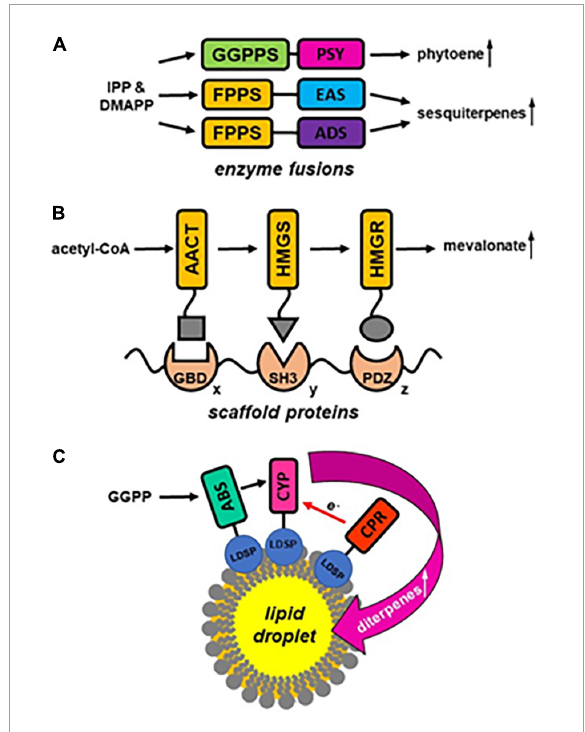
FIGURE2 Engineering approaches utilizing metabolic channeling for improved terpenoid formation. (A) Enzyme fusion strategy: fusion of prenyltransferases (GGPPS, FPPS) with phytoene synthase (PSY) and terpene synthases ( epi -aristolochene synthase EAS, amorpha-4,11-diene synthase ADS), respectively, leads to increased substrate (IPP, DMAPP) conversion to product formation. (B) Synthetic scaffold protein strategy: scaffold proteins carry multiple protein-protein interaction domains (GBD, SH3, PDZ) in various ratios (x: y: z) to organize multiple sequential pathway enzymes (e.g., AACT, HMGS, HMGR) tagged with specific small peptide ligands (indicated by a square, triangle and circle) to increase metabolic flux through a pathway. (C) Lipid droplet strategy: engineered cytosolic lipid droplets serve as scaffold to co-localize terpenoid biosynthetic enzymes, e.g., diterpene synthase abietadiene synthase (ABS), cytochrome P450 (CYP), and cytochrome P450 reductase (CPR), that are expressed as fusion constructs with a lipid droplet surface protein (LDSP). It will result in increased production of terpenoid compounds (e.g., diterpenes) and additionally in